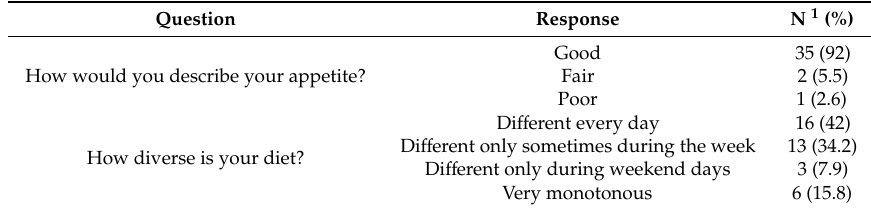
Table 7. General eating habits of the study participants.